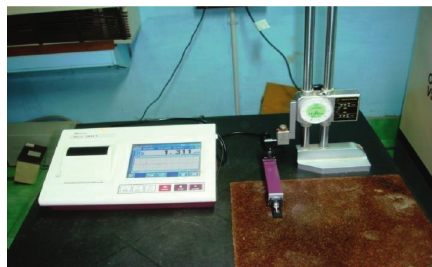
Figure 3: Surface roughness tester photographic picture (Mitutoyo